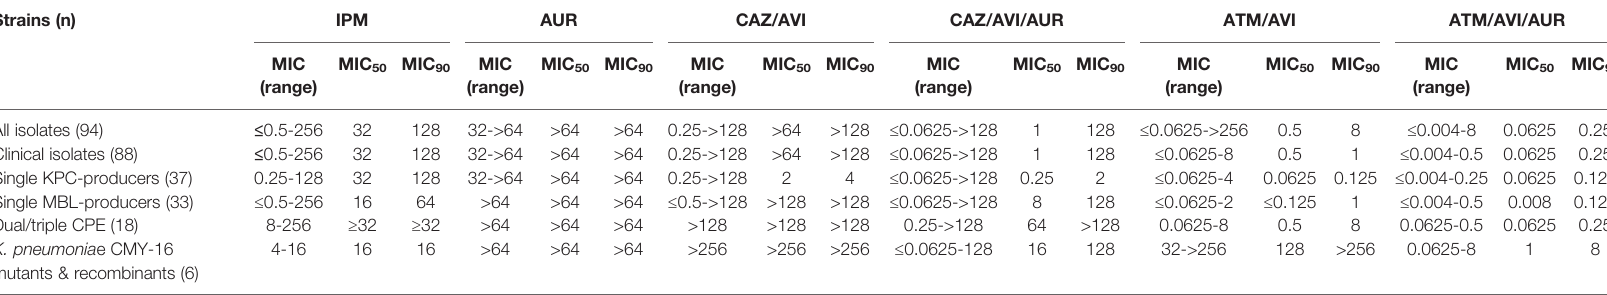
mutants & recombinants (6)